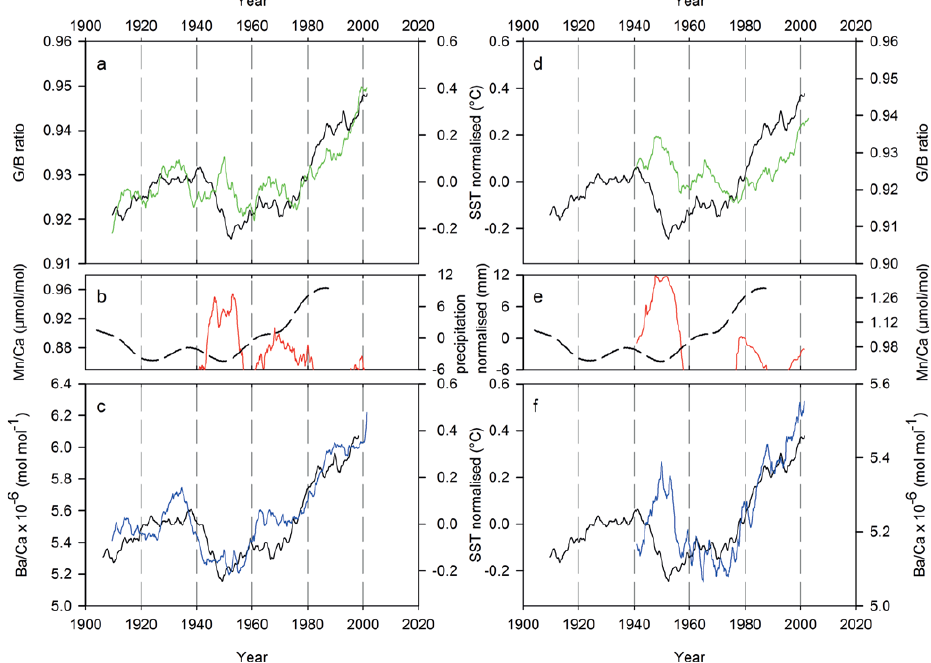
Fig. 6. An 11yr running mean of MAS1 and MAS3 coral G/B (green) compared to the SST anomaly (ERSSTv.3) for the southern central Indian Ocean 5–20 ◦ S, 60–90 ◦ E (black) since 1904 ( a , d ), the coral Mn/Ca (red solid; µmolmol − 1 ) ( b , e ), and the Ba/Ca (blue) ( c , f ). Note that multidecadal oscillations in G/B and Ba/Ca show high coherence with SST. Higher Mn/Ca ratios identify periods of slash-and-burn deforestation that overprint the climatic control of humic acid runoff. Differences observed between Ba/Ca and G/B are linked to watershed composition. A 360-month low pass filter of Antananarivo precipitation anomalies (18.80 ◦ S, 47.50 ◦ E, 1276m, WMO station code: 67083 ANTANANARIVO/IVATO) is shown (black dashed; b , e ), indicating increasing rainfall conditions until 1987. Note that this precipitation record ends in 1987 due to recent data